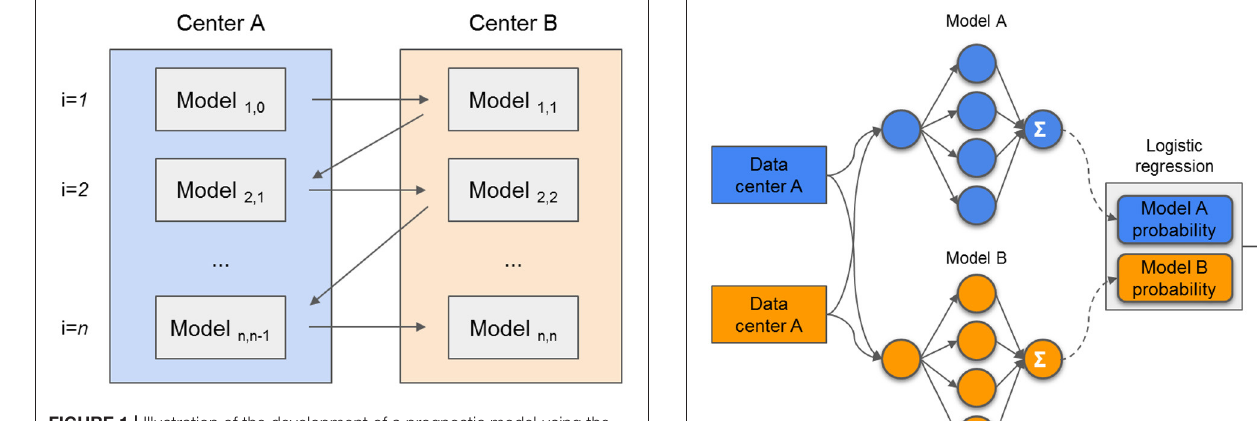
FIGURE 1 | Illustration of the development of a prognostic model using the Cyclic Weight Transfer approach. The model is being trained by two different centers in an iterative fashion. Each model version is trained and exchanged between centers for n iterations or until a stopping criterion is reached.